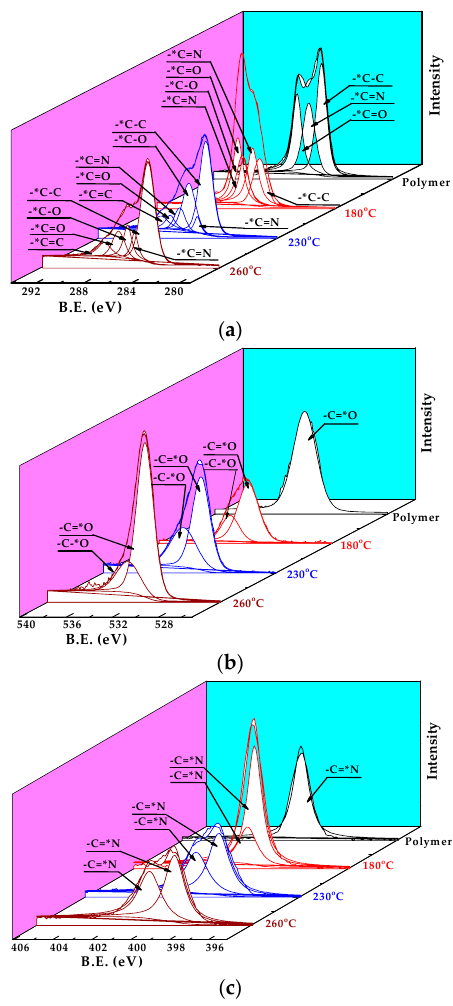
Figure 3. The C1s ( a ), O1s ( b ) and N1s ( c ) core levels of polymer membrane and CLA-PAN membranes prepared at different cross-linking